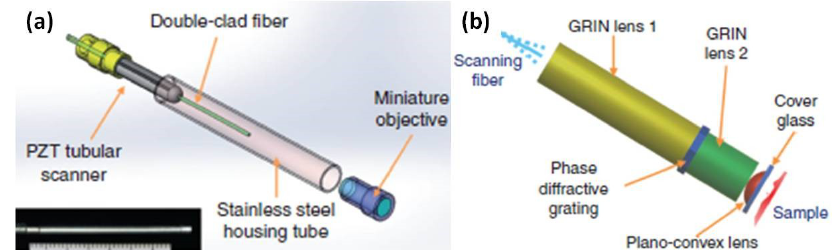
Figure 14. Fiber optic scanning two-photon endomicroscope. ( a ) Schematic drawing of the mechanical assembly based on double cladding fiber (DCF), the bottom inset is the photograph of the endomicroscope with an outer diameter of about 2.1 mm and a rigid length of about 35 mm. ( b ) Miniature custom-made objective and longitudinal focal shift. A phase diffractive grating is sandwiched between two GRIN elements. The fiber- and sample-side WDs are designed to be 200 µm in air and water. Reproduced with permission from [85]; published by Nature, 2017.